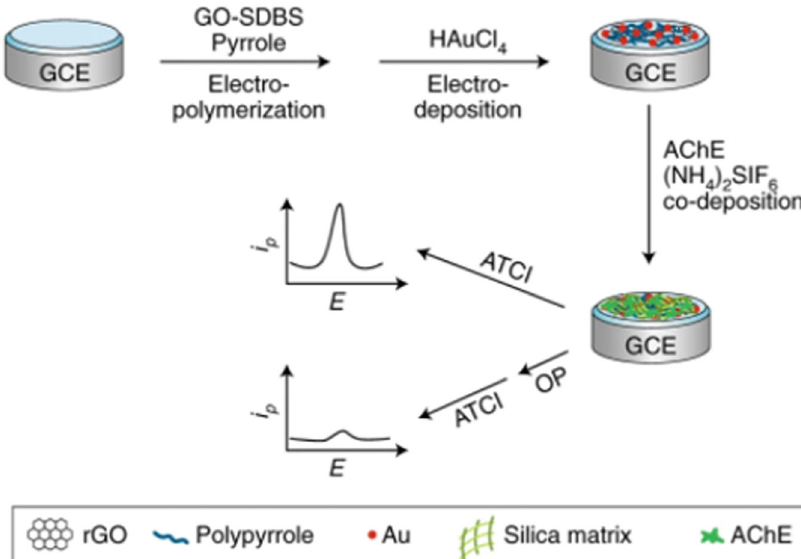
Fig. 9 Electrically based nanosensor architecture for environmental analyte detection. A glassy carbon electrode was functionalized via multiple steps, including the treatment with reduced graphene oxide, electro polymerization of pyrrole, electrodeposition of gold, and the co- deposition of silica and acetylcholinesterase (reprinted with permission from 182 ; Copyright © RSC,